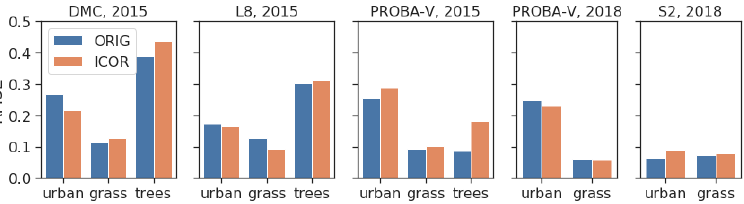
Figure 7. RMSE between in situ data and sensor data for different classes (X-axis) and for ‘original’ and ‘ICOR’ data (colors).